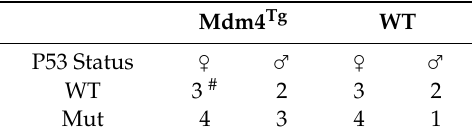
Table 1. P53 status in fibro-sarcoma of Mdm4 Tg and WT